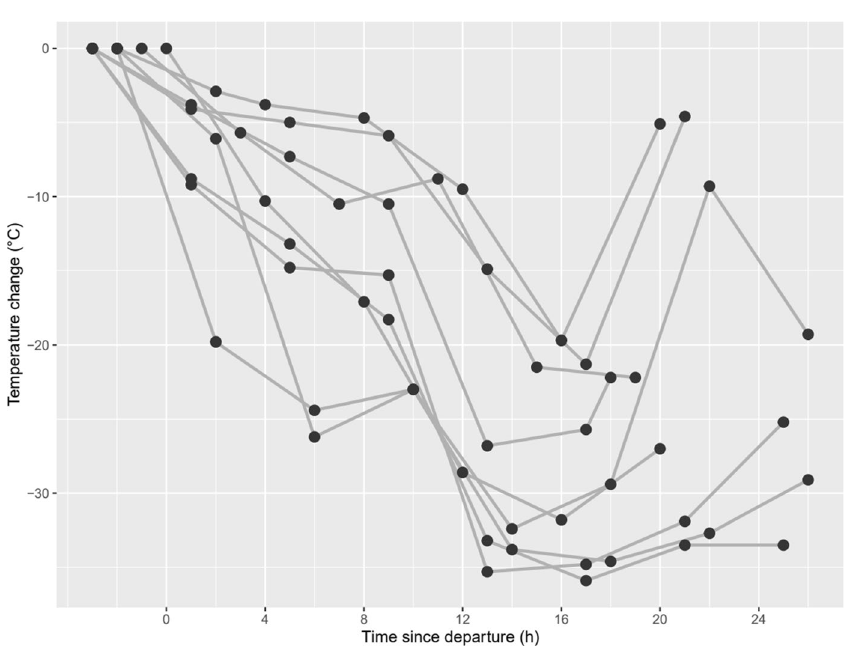
Figure 5. Temperature changes recorded by geolocators on Common Redshanks at the start of the initial northward flight from the tropical non-breeding grounds (nine records from eight